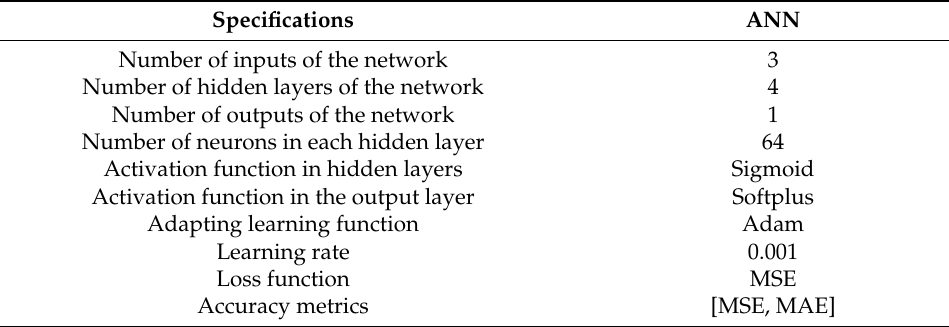
Table 4. Final specifications of the ANN for the SOC estimation.